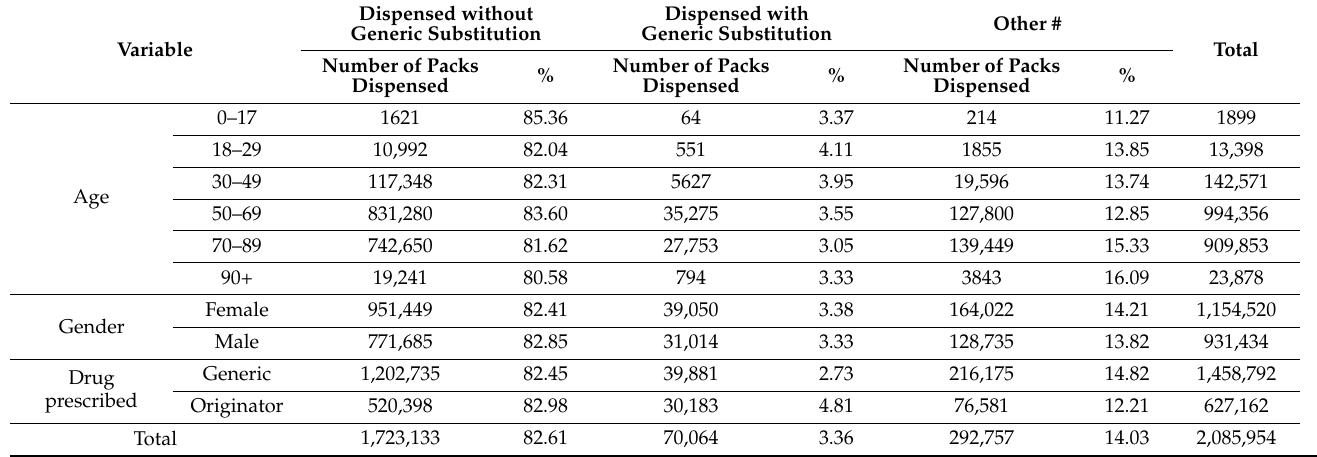
Table 2. The analysis of dispensation of metformin e-prescriptions issued in Poland in 2019 (data refer to the dispensation period between 1 January–31 December 2019); # other forms of dispensation which do not satisfy the definition of generic substitution, such as dispensation of a pack with a dosage or a number of units other than those prescribed, other formulation (e.g., an immediate-release formulation instead of a modified-release one), etc.